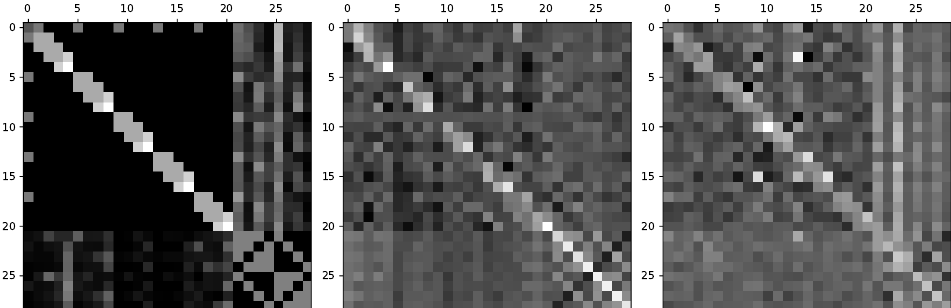
Figure 6. Visualization of the general relation graph and the learned interaction-specific relation graphs in different HOI scenarios. The left matrix is the general relation graph in the FPHA-HO dataset. The middle matrix is an example of the interaction-specific relation graph learned by our InterGCN in “pouring juice bottle”. The right matrix is another example of the interaction-specific relation graph for “closing juice